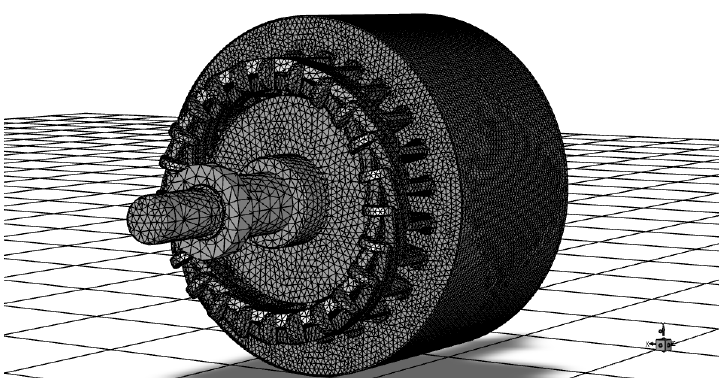
Figure 8. Meshing results of the DSOF motor.